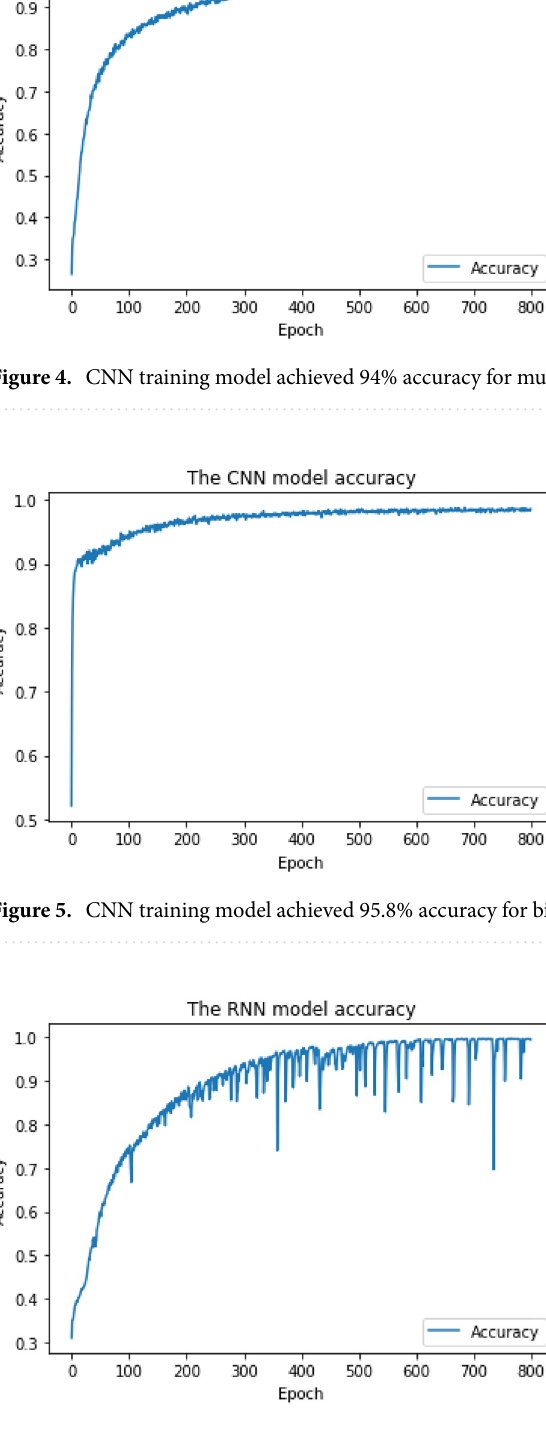
Figure 6. RNN training model achieved 85.6% accuracy for multiclass